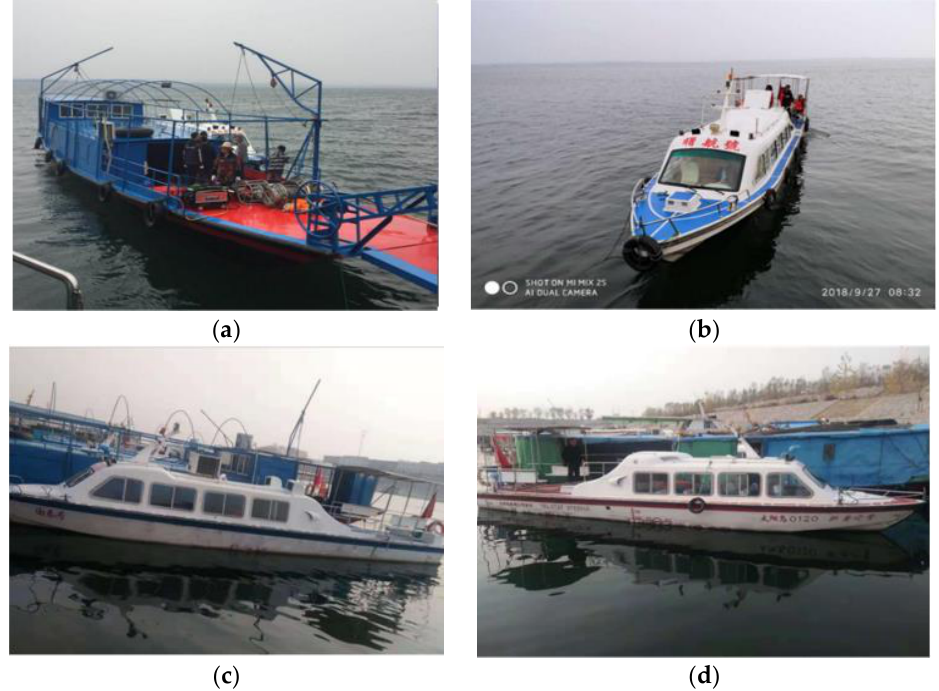
Figure 8. Four types of targets. ( a ) Tin Ship. ( b ) Shu hang. ( c ) Guo tai. ( d ) New Century.